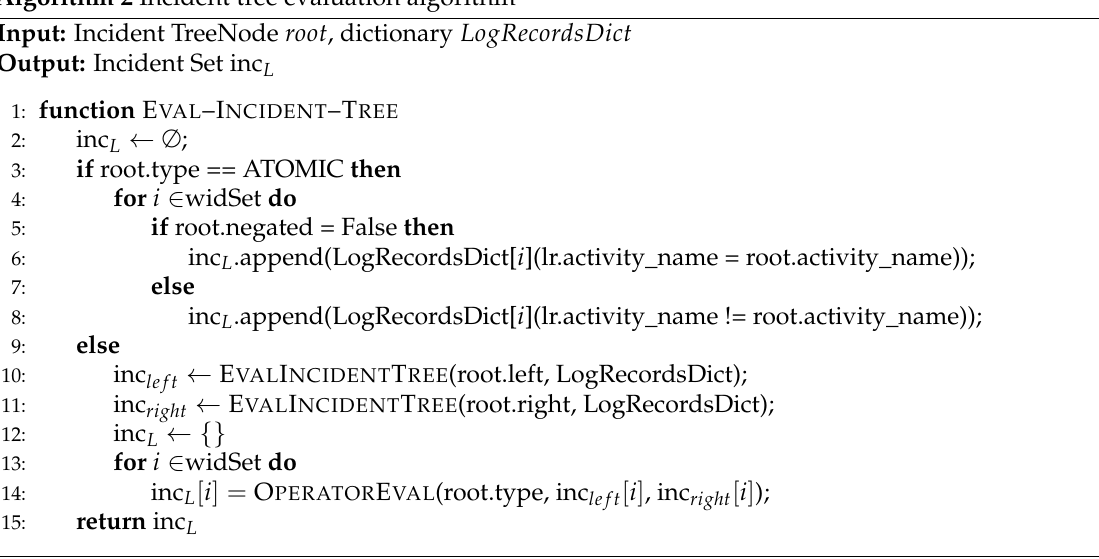
( UpdateRefer GetRimburse ). (cid:12) (cid:12)